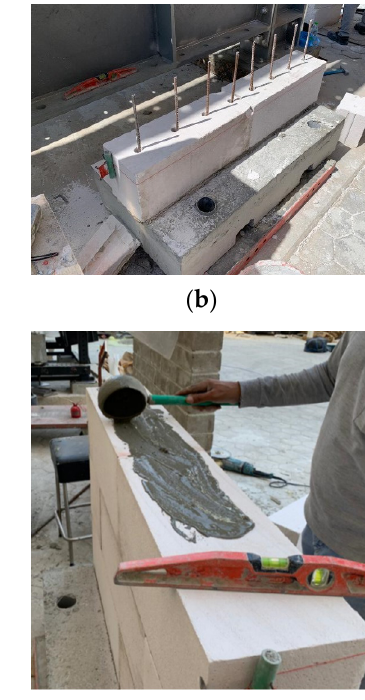
Figure 10. Details of the reinforced wall with dimensions in mm.